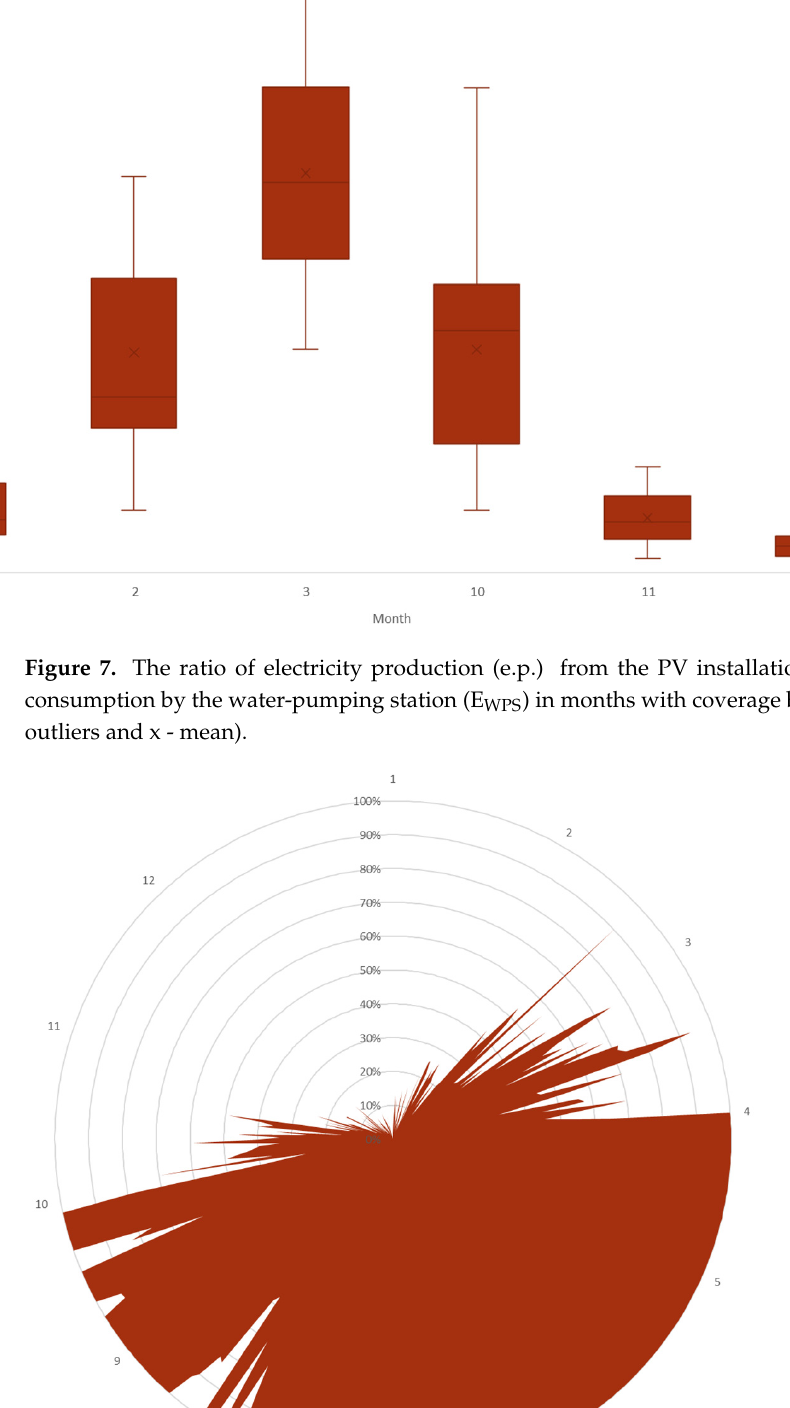
Figure 9. Days with a surplus of electricity production from PV over the demand of WDS during the year. It was assumed that negative values on the y -axis mean the need to collect electricity from the power grid, payment for the energy consumed, and positive values on the y -axis